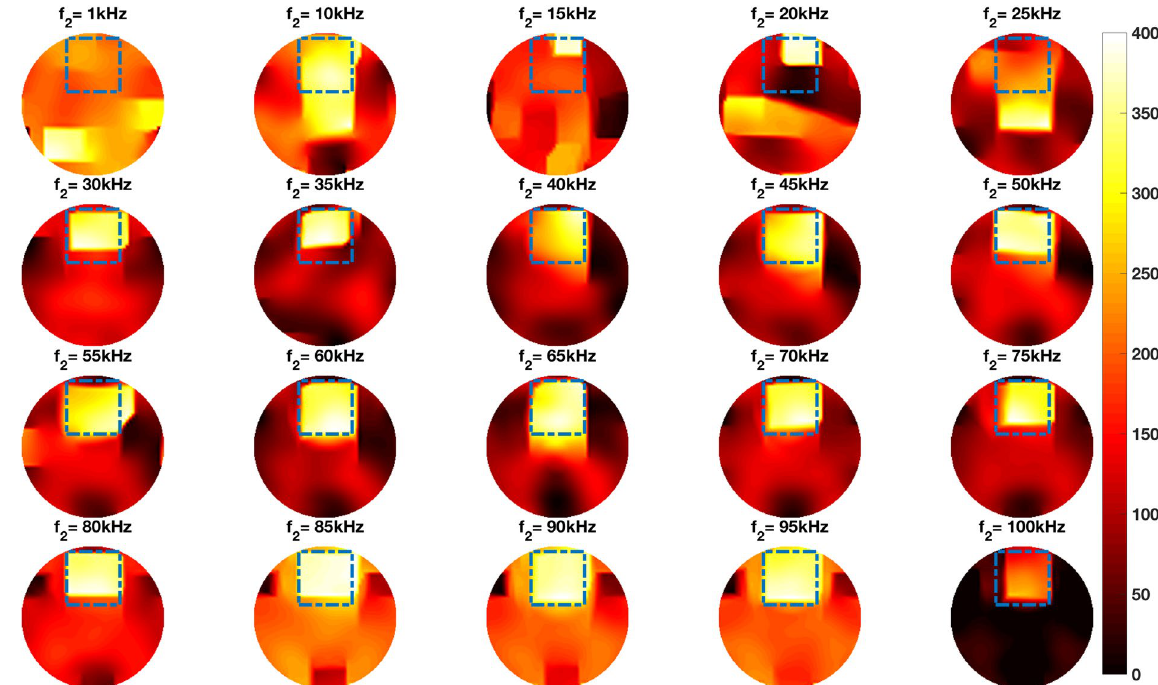
Figure 10. Reconstructed frequency difference images of an aluminium rod (D42.00 mm, H44.00 mm) and a steel cube (side length 38.00 mm) positioned side by side in the imaging region (experimental setup shown in Fig.